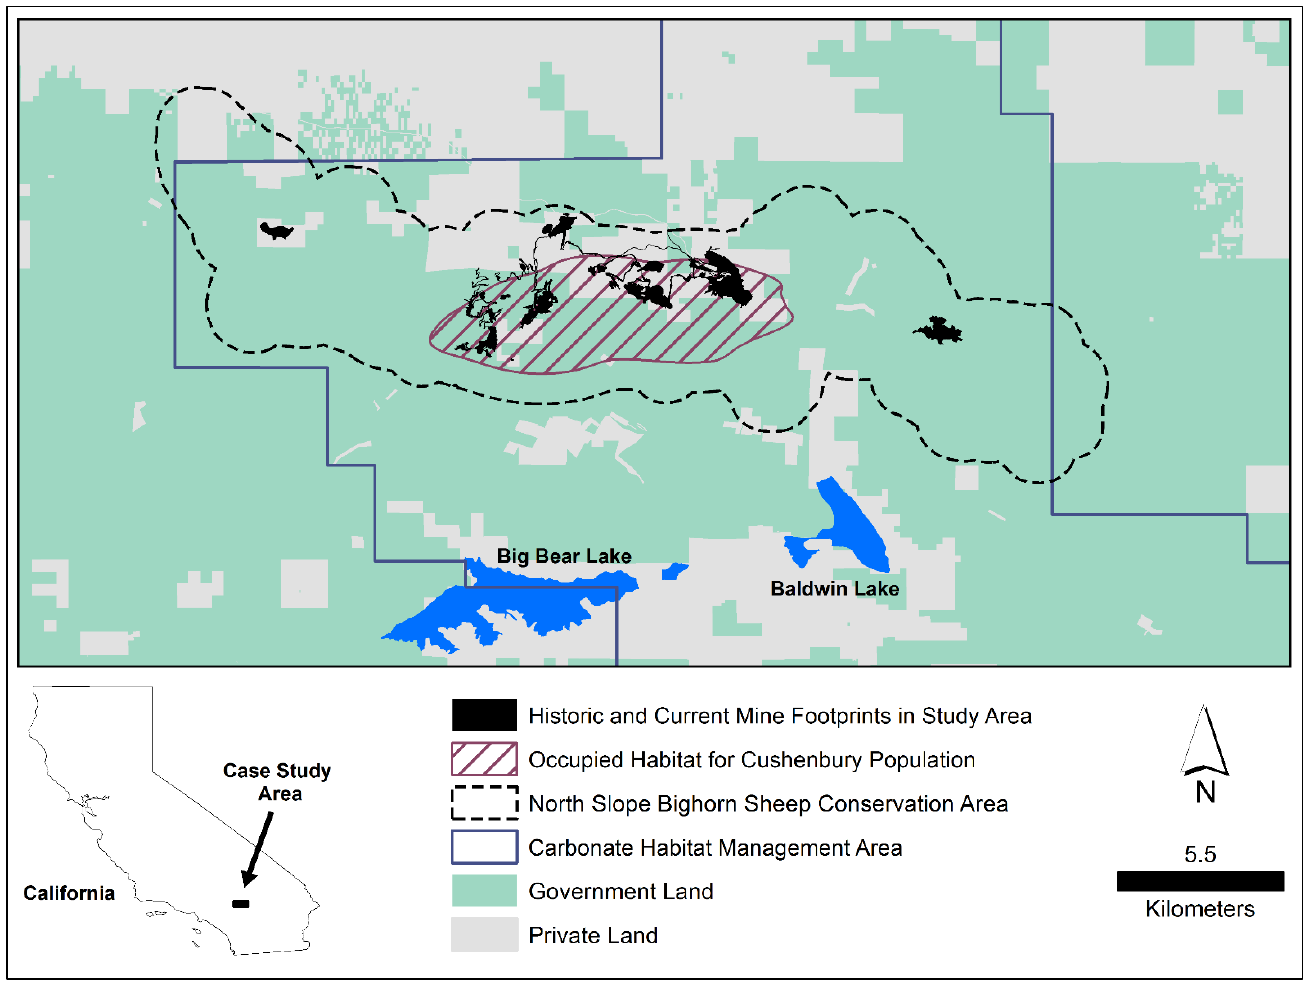
Figure 1. North Slope Bighorn Sheep Conservation Area, San Bernardino Mountains, California, USA.